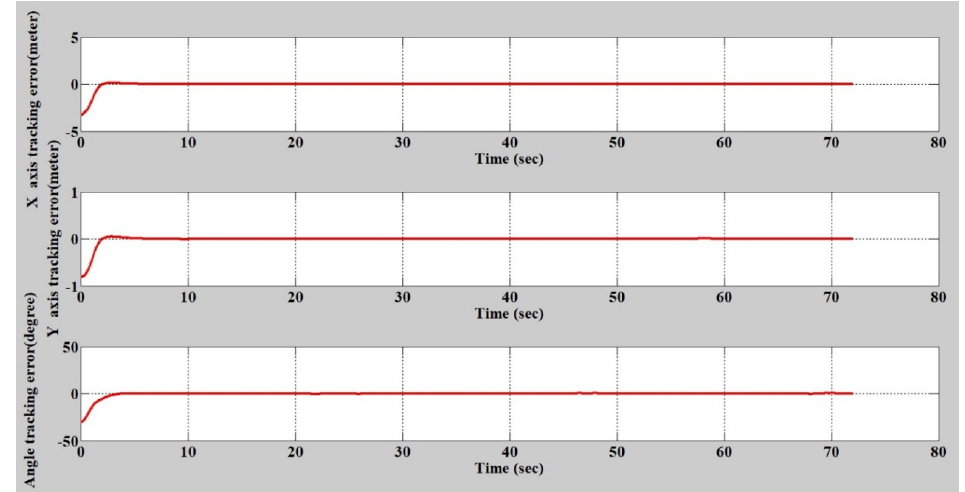
= 1.9 m, y = 0 m). c c